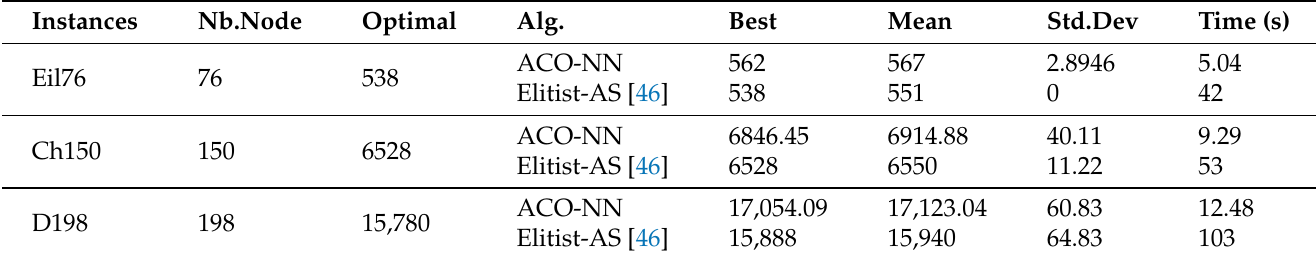
Table 4. Comparison of ACO-NN to Elitist-AS for Eil76, Ch150, and D198.